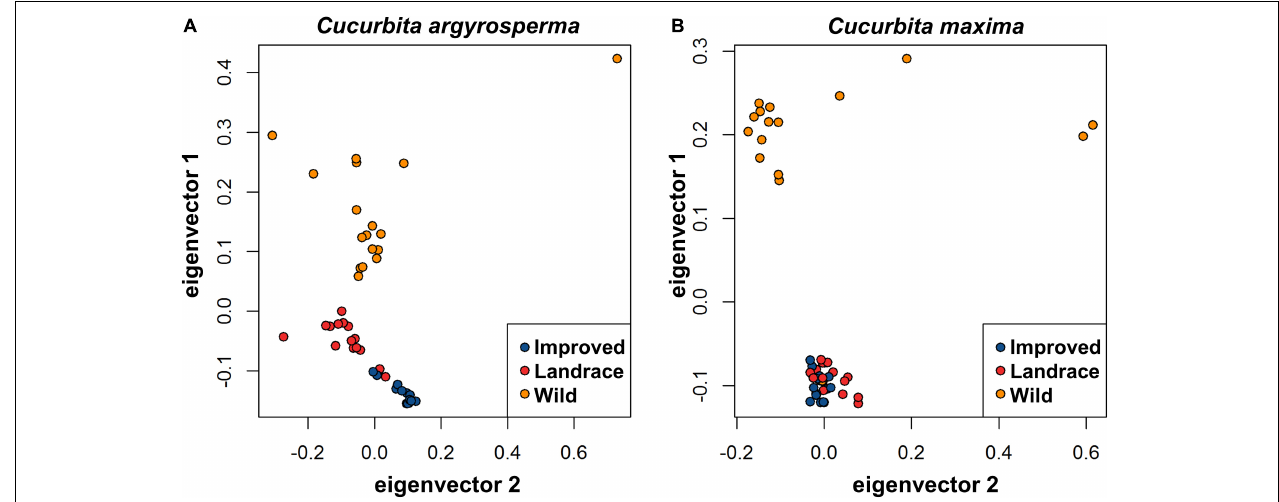
FIGURE 3 | Principal component analysis of improved (blue), landrace (red), and wild (orange) (A) C. argyrosperma accessions and (B) C. maxima accessions based on 2,024 SNPs for C. argyrosperma and 1,926 SNPs for C. maxima . For C. argyrosperma , the percent of variation accounted for by eigenvector 1 and eigenvector 2 is 9.0 and 5.2%, respectively. For C. maxima , the percent of variation accounted for by eigenvector 1 and eigenvector 2 is 8.8 and 6.7%,